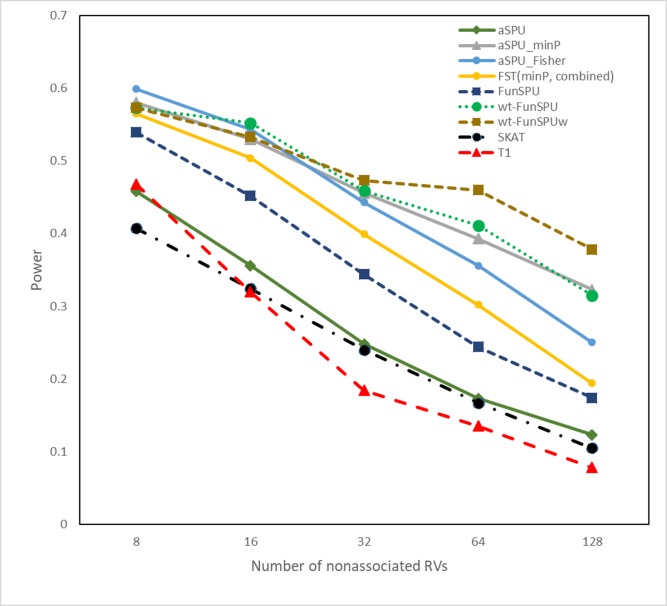
Empirical power of various tests for eight causal RVs and increasing number of nonassociated RVs at significance level α = 0.05.The incorporated annotations for association tests include all three informative annotations and three noninformative annotations (Scenario A). All the results were based on 1000 simulation replications.